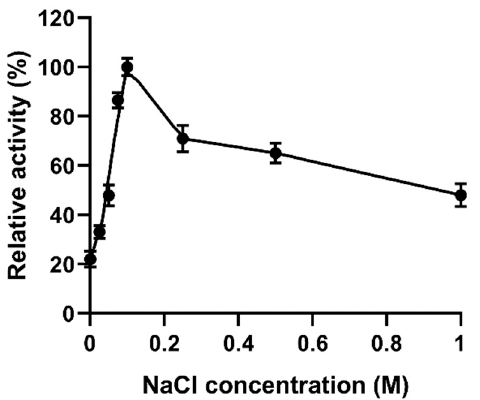
Figure 8. Effect of NaCl on enzyme activity of YsHyl8A. The activity of YsHyl8A at the optimal NaCl concentration was defined as 100%. Error bars indicate the standard deviation ( n = 3).